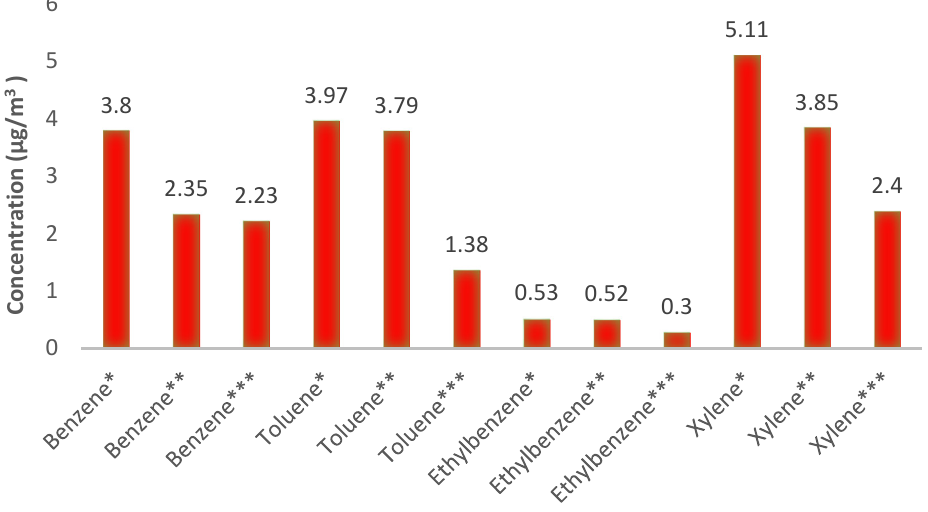
Figure 2. The mean concentration of BTEX compounds in the ground floor restaurant units (*), upper residential units of the residential-commercial complexes (**), and control residential units (***). Table 2. The mean and standard deviation for the studied units.